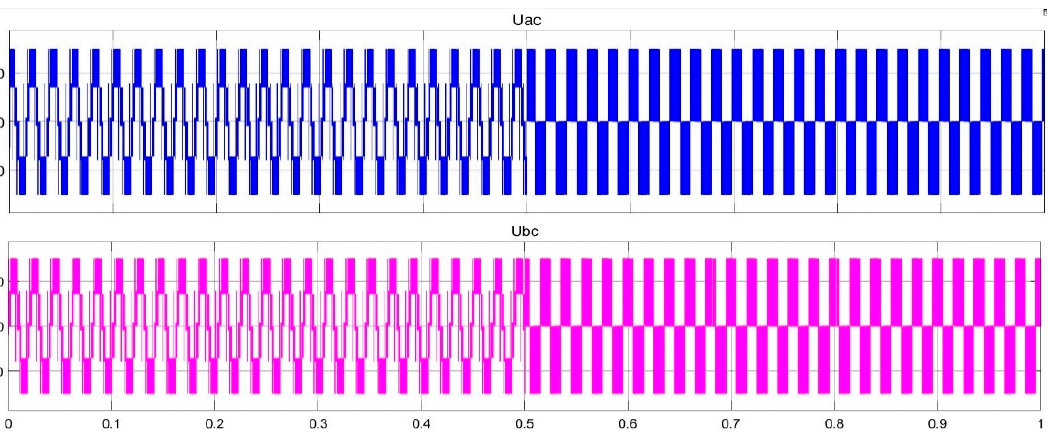
Figure 15. The simulation voltage waveform of three–two-level modulation conversion.